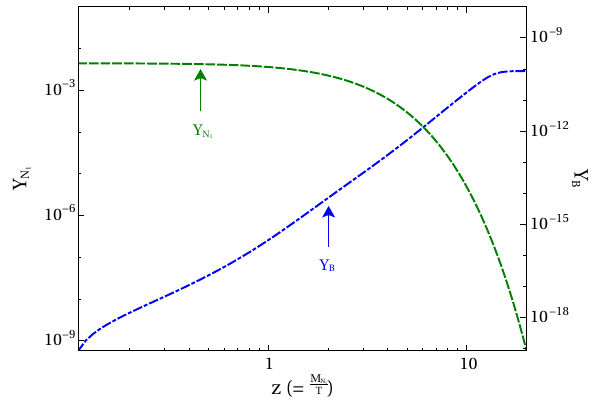
Fig. 5 Variation of Y N (green dashed line) and Y B − L (blue dashed- 1 dotted line) with z where the other parameters have been kept fixed at